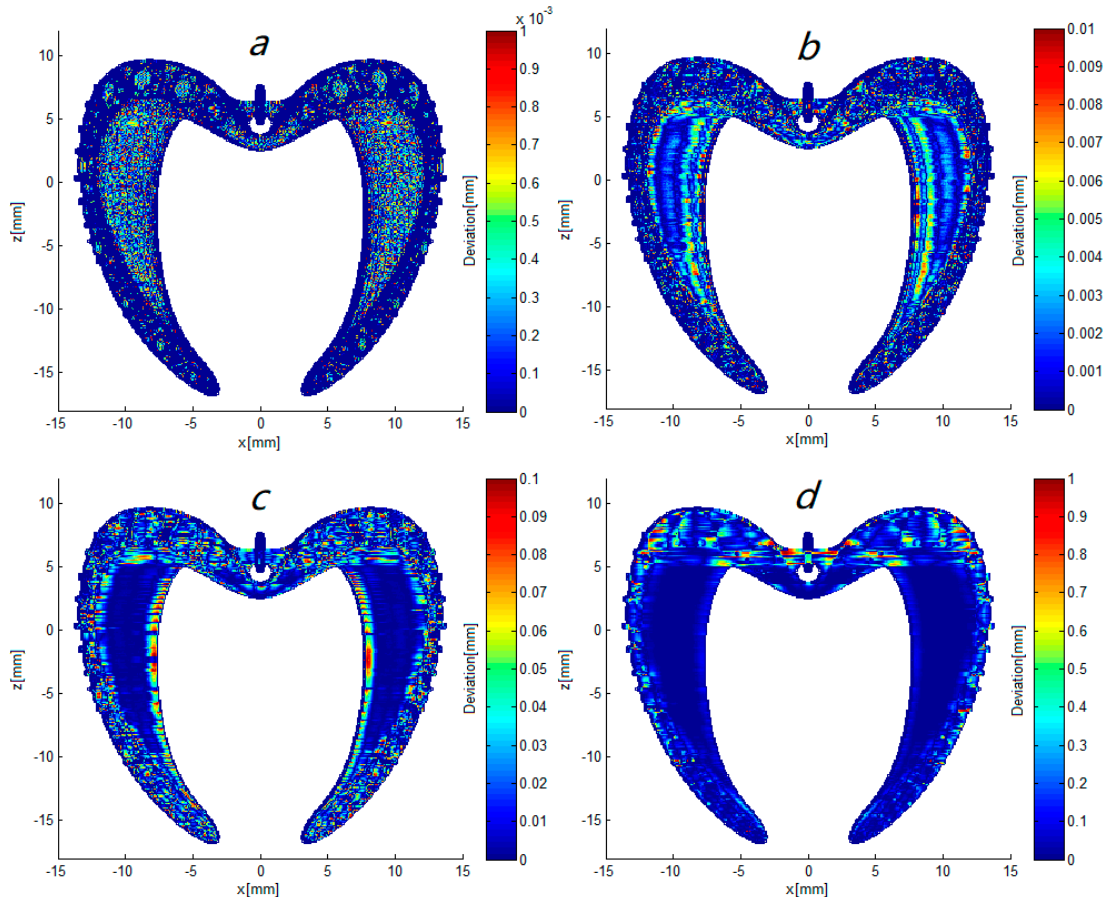
Figure 14. Spatial distributions of deviation under different required accuracies ε : ( a ) ε = 0.001